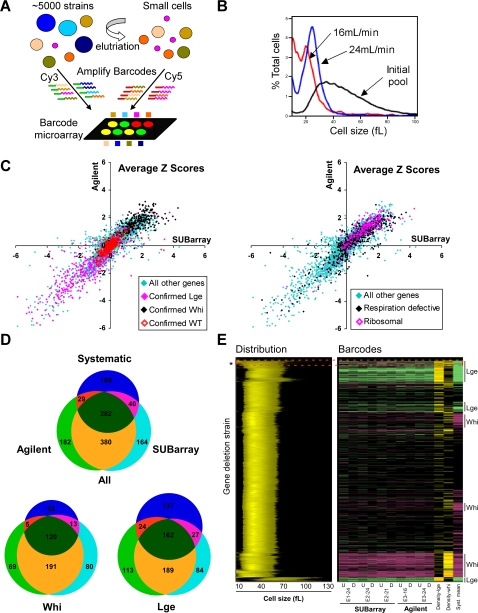
Barcode elutriation cell size experiment.A. Schematic of the experiment. Elutriation of the haploid pool enriches for small cells. Genomic DNA is isolated from cell populations immediately before and immediately after elutriation, differentially labeled with either Cy5 or Cy3, and applied to a barcode microarray. B. Cell size distributions of a characteristic elutriation as determined by use of a Coulter Z2 particle analyzer (Beckman). Increasing the rate of flow through the elutriation rotor increases the median cell size of the elutriated fraction. C. Scatter plot of the average barcode Z score. Agilent (Y axis). SUBarray (X axis). Left. Overlay of barcodes of strains confirmed as either lge (black), whi (magenta), or wild-type (WT; red) by systematic experiments [28] on all other barcodes (blue). Right. Overlay of barcodes of structural components of the cytosolic or mitochondrial ribosome (magenta) or respiration defective strains [32] (black) on all other barcodes (blue). D. Venn diagrams of overlap between systematic and barcode data using SUBarrays or Agilent arrays. Cell size mutants are as defined in the text. E. Overlap between systematic and barcode data. Clustered cell size distributions are represented by horizontal bars color coded by intensity to reflect the shape of the distributions, with deletion strains on the vertical, and cell size on the horizontal axis. Barcodes, divided into UP (U) and DN (D) tags, with Z scores greater than 1 are represented as Lge (green bars) or Whi (red bars) adjacent to their cognate deletion strain for all experiments (E1, E2, E3) and all elutriation cuts (16, 21, 24 mL/min). SUBarrays and Agilent arrays are shown. The density of lge or whi barcodes (Z score>1) over a 3 gene window is represented by horizontal bars color coded by intensity (>10% brown; >30% yellow; >70% orange). Only barcodes with significant intensity/SNR were used in density calculations. Gene deletion strains with systematic mean cell sizes >1 SD larger (green) or smaller (red) than average are shown. Systematic lge strains with broad distributions and unexpected cell size by barcode are indicated (dotted red box and asterisk).